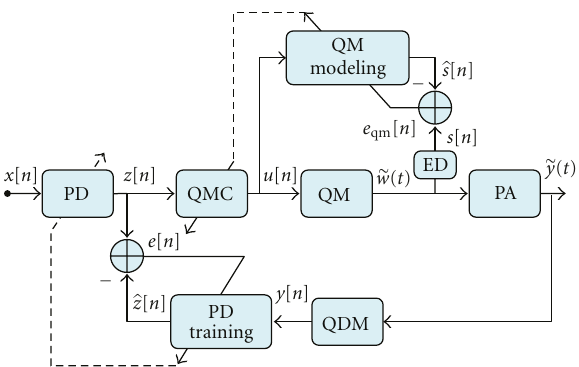
Figure 8: The proposed adaptive compensator structure in con- junction with the MOP PD.